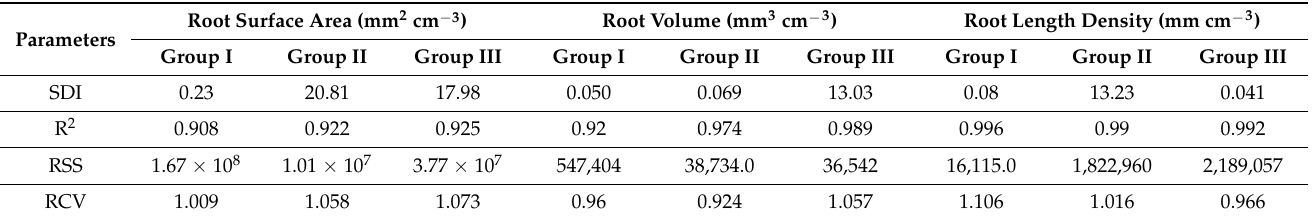
Figure 1. Dissimilarity between six C. canephora genotypes using the Euclidean distance of the means and the single-link clustering method—nearest neighbor, considering four root characteristics (root length density, root volume, root surface area and root diameter), based on three distances in the planting row (16, 32 and 48 cm) and nine distances in inter-row planting (16, 32, 48, 64, 80, 96, 112, 128, 144 cm). Both the distances were measured from the stem of the plant and six depths from the ground (0–10, 10–20, 20–30, 30–40, 40–50 and 50–60 cm) at each distance. Table 2. Estimated parameters of experimental semivariograms for the studied variables of the groups of six genotypes of C. canephora in Nova Ven é cia—Esp í rito Santo, Brazil.